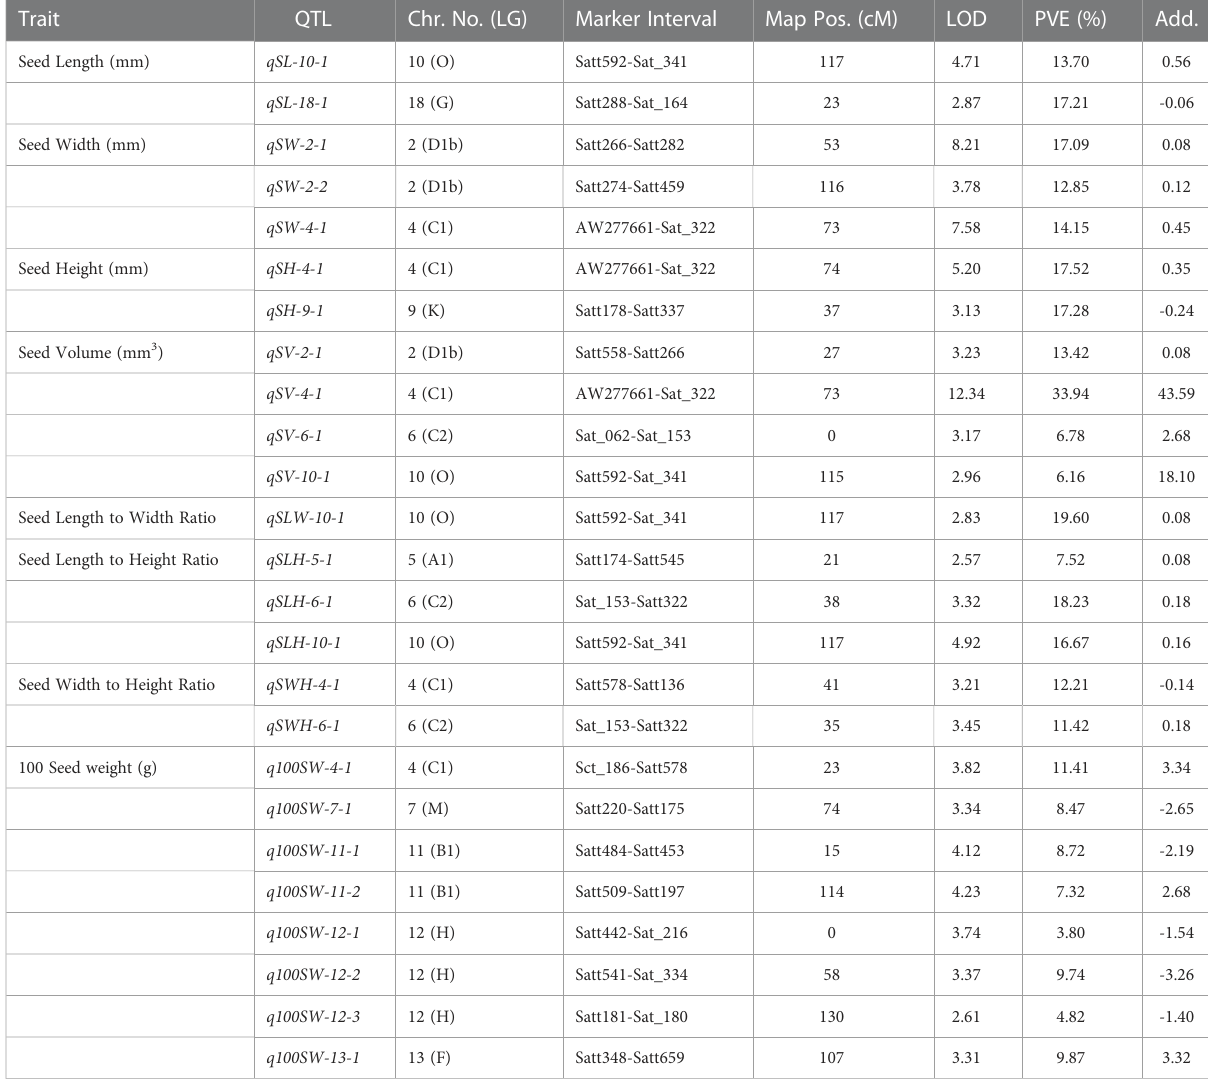
TABLE 5 QTLs identi fi ed for yield-related traits in the F 2:3 mapping population derived from AGS 457 X SKAF 148. Trait QTL Chr. No. (LG) Marker Interval Map Pos. (cM) LOD PVE (%)